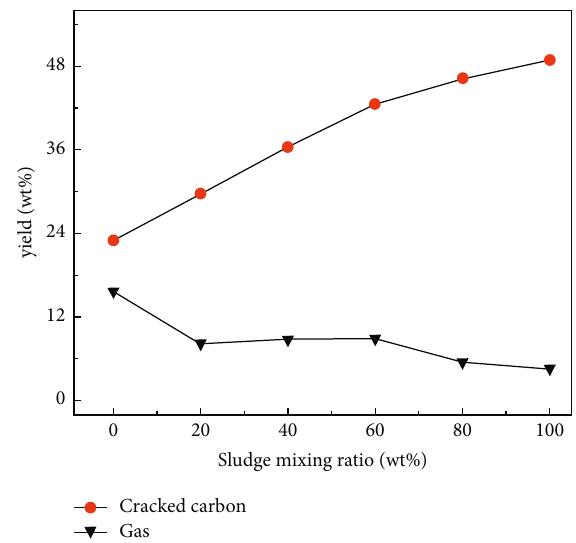
Figure 9: Copyrolysis curve of peanut shell and sludge oil yield with the blending ratio.